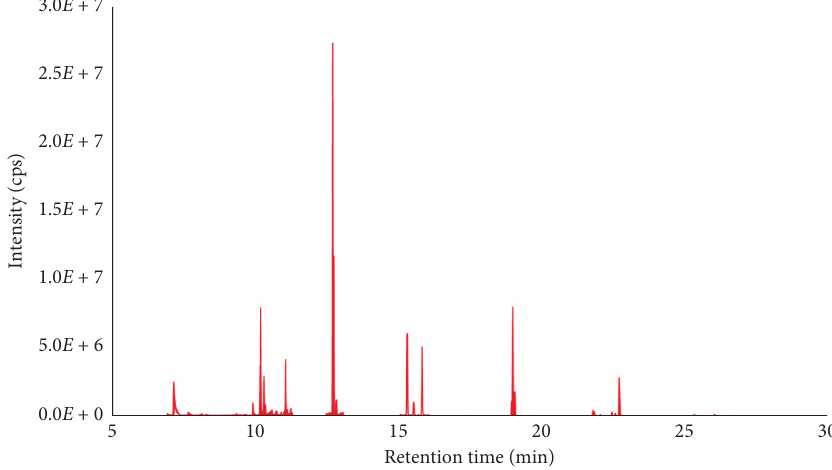
Figure 3: Total selected ion chromatogram of PAHs in real sample. Table 4: TEF of 16 PAHs and TEQ of PAHs in the investigated